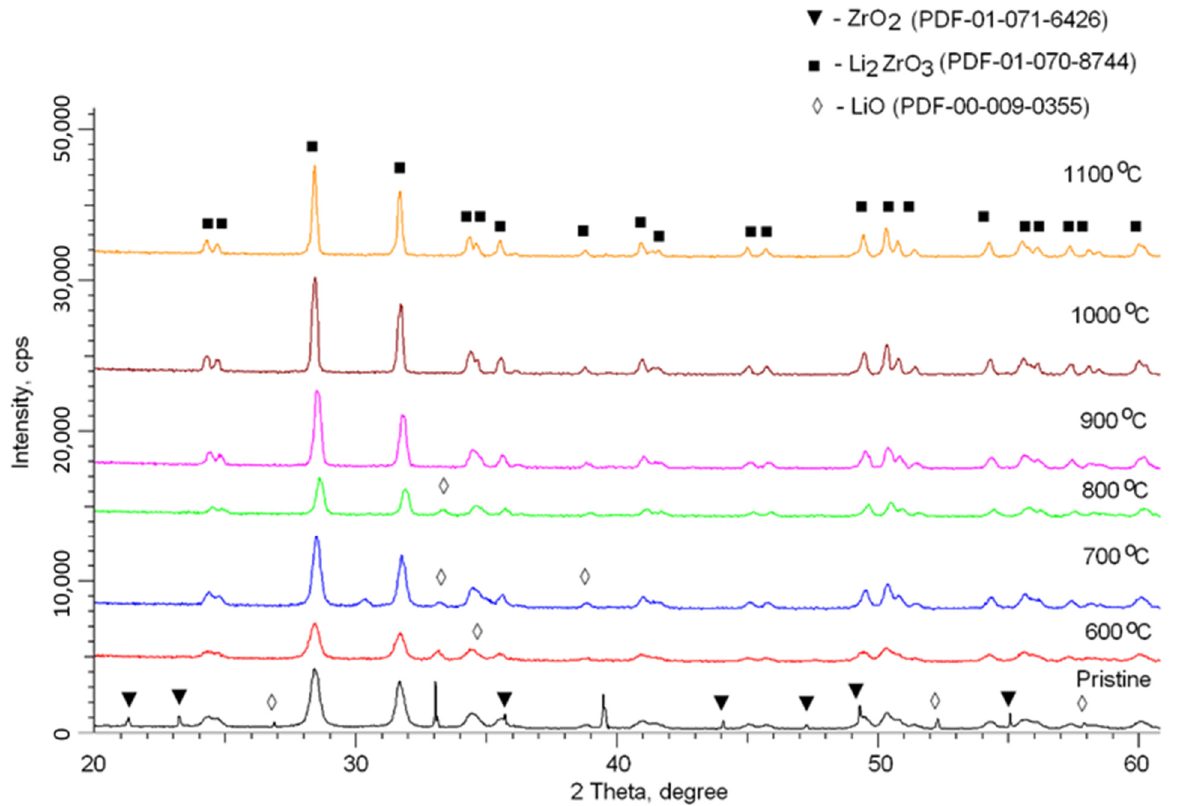
Figure 2. X-ray diffraction patterns of the studied ceramics versus annealing temperature.